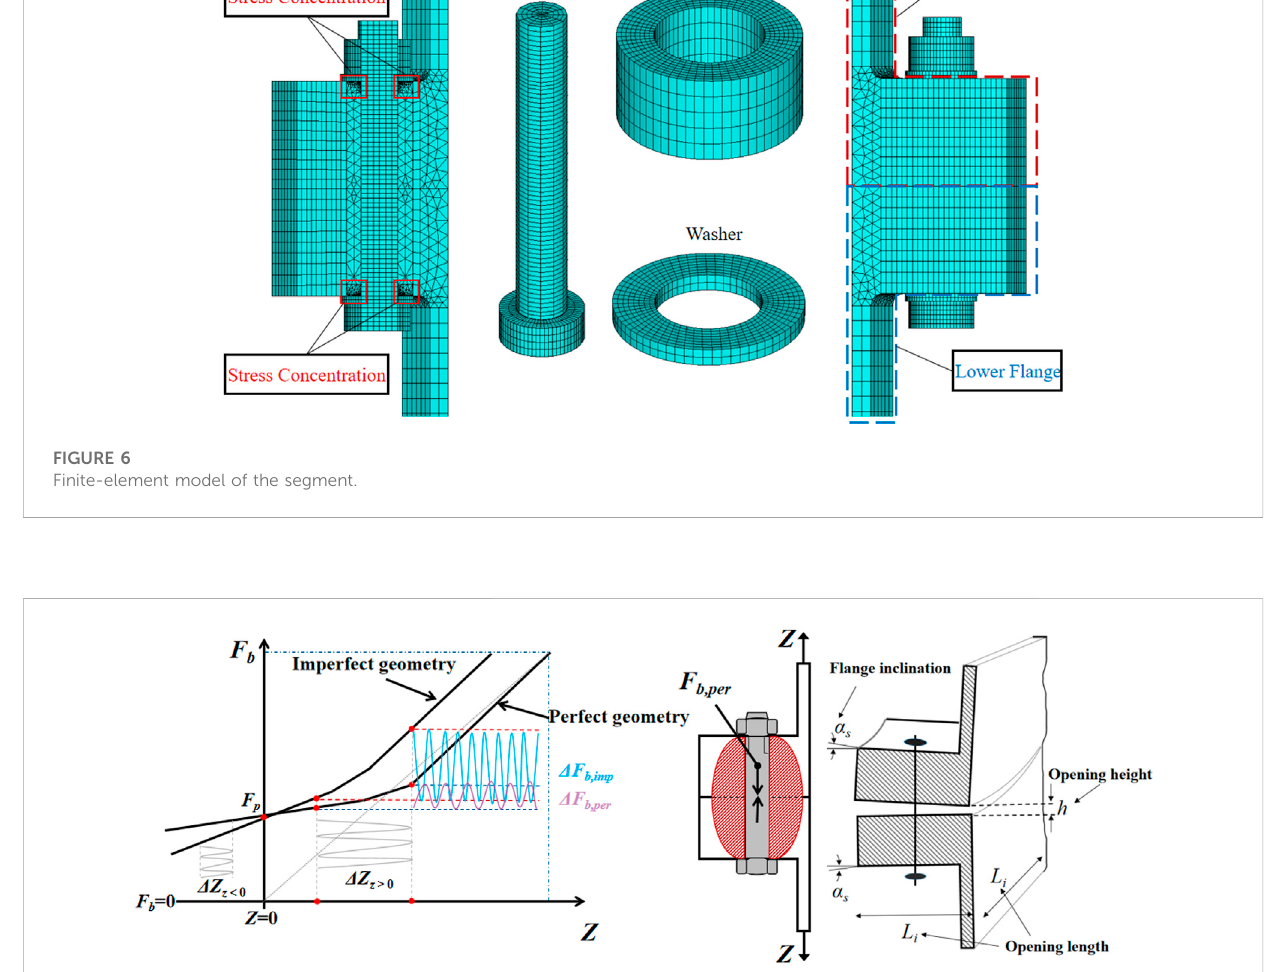
Frontiers in Energy